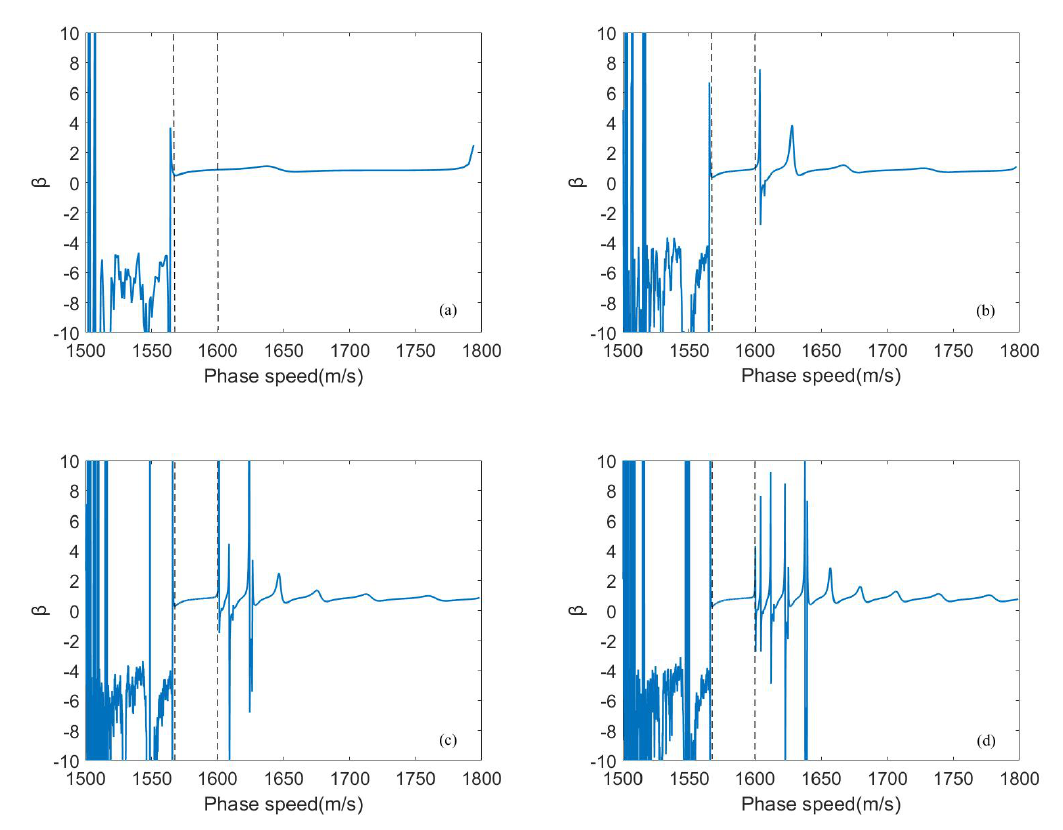
Figure 5. The dependence of waveguide invariant ( WI) on phase speed and frequency. ( a ) Frequency is 50 Hz ； ( b ) frequency is 150 Hz; ( c ) frequency is 250 Hz; ( d ) frequency is 350 Hz.